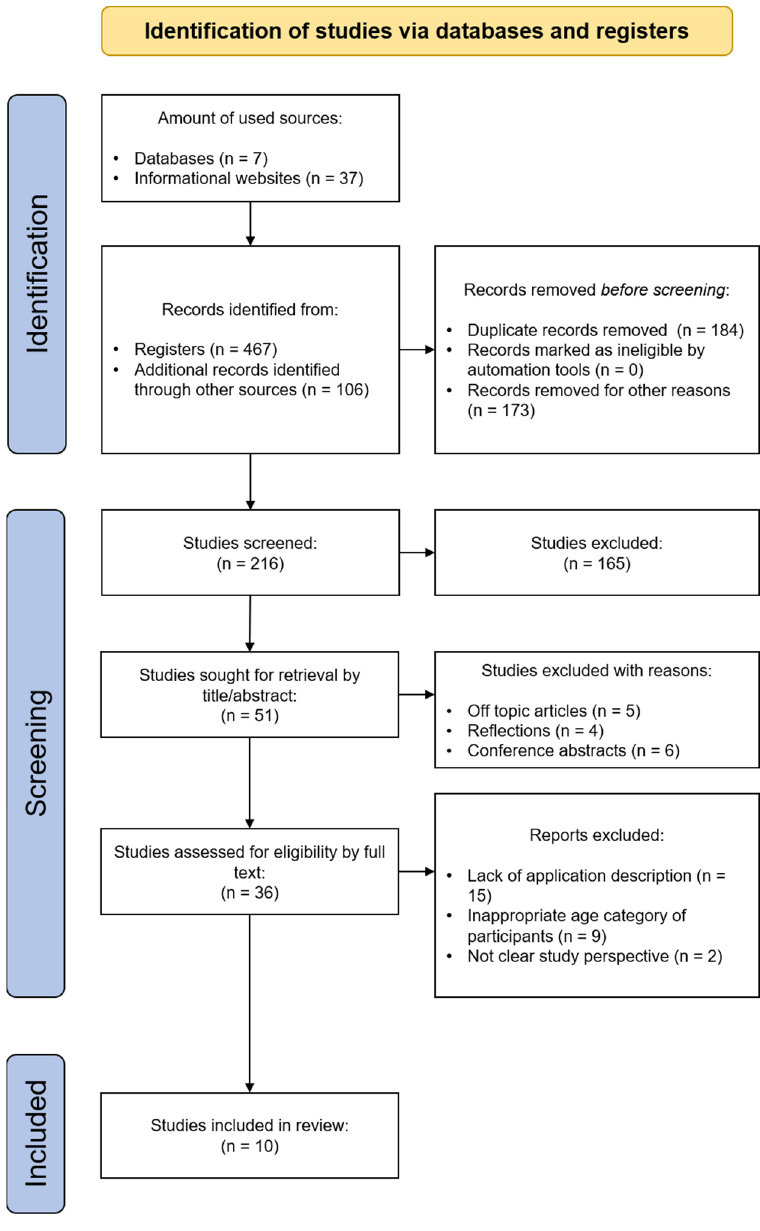
Figure 1. Flow chart. Table 3. List of criteria for the analysis of articles’ quality